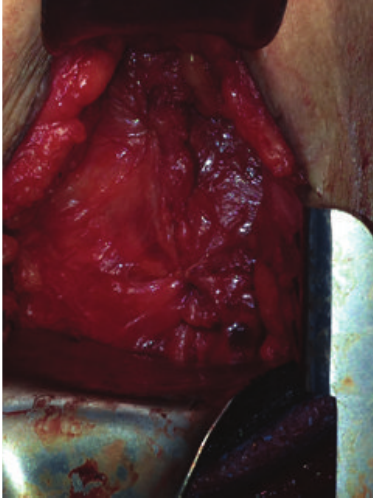
Figure 5: Exposure of defect.